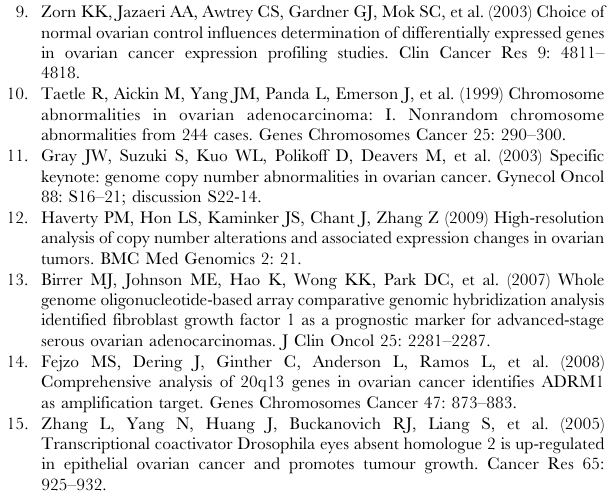
Table S4. (B) Shows the rules used to eliminate CNPs from the cytoband regions. Regions such as ‘‘Amp 4’’ are split into two, resulting in more regions after CNP elimination than before. (C)